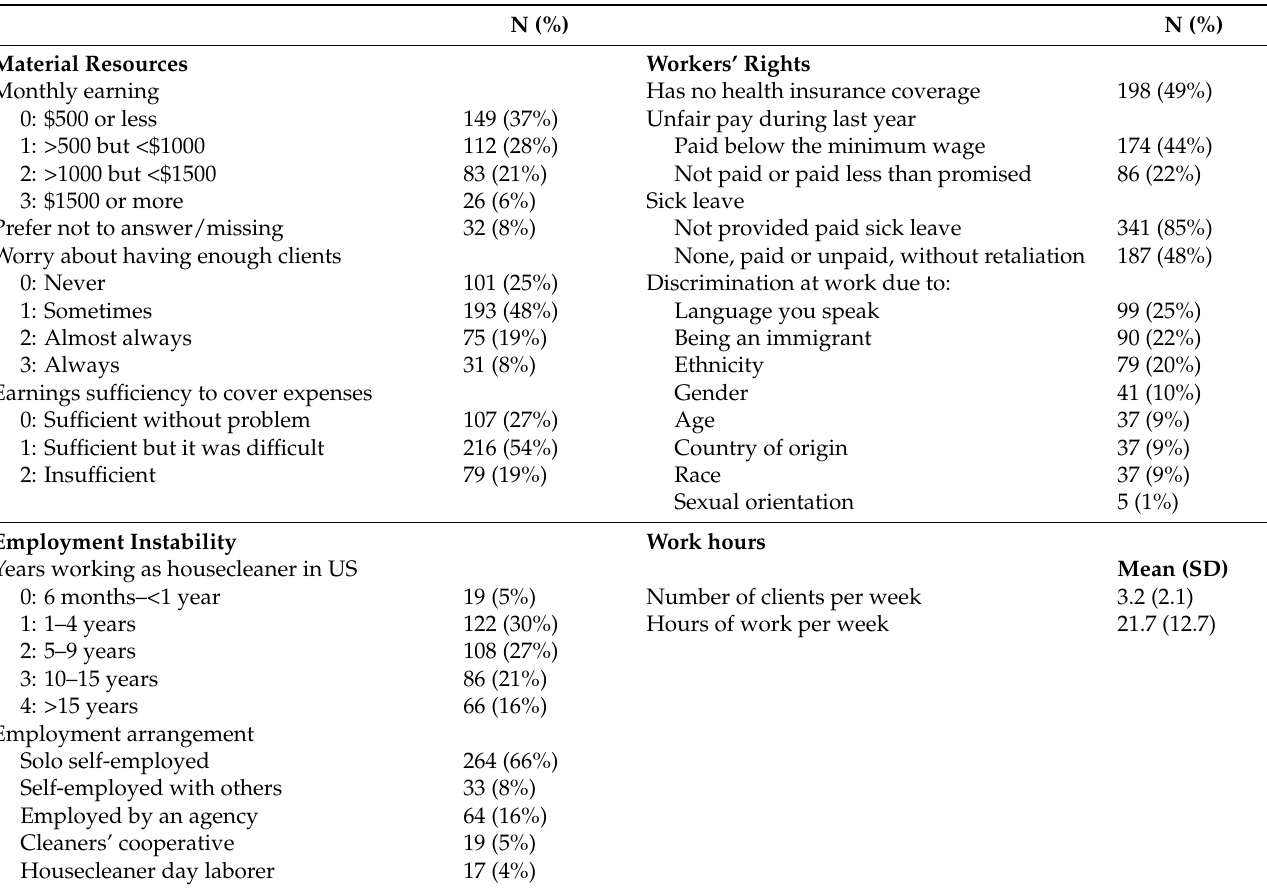
Table 1. Participant Employment Quality Indicators: Safe and Just Cleaners Study. N (%) N (%) Workers’ Rights